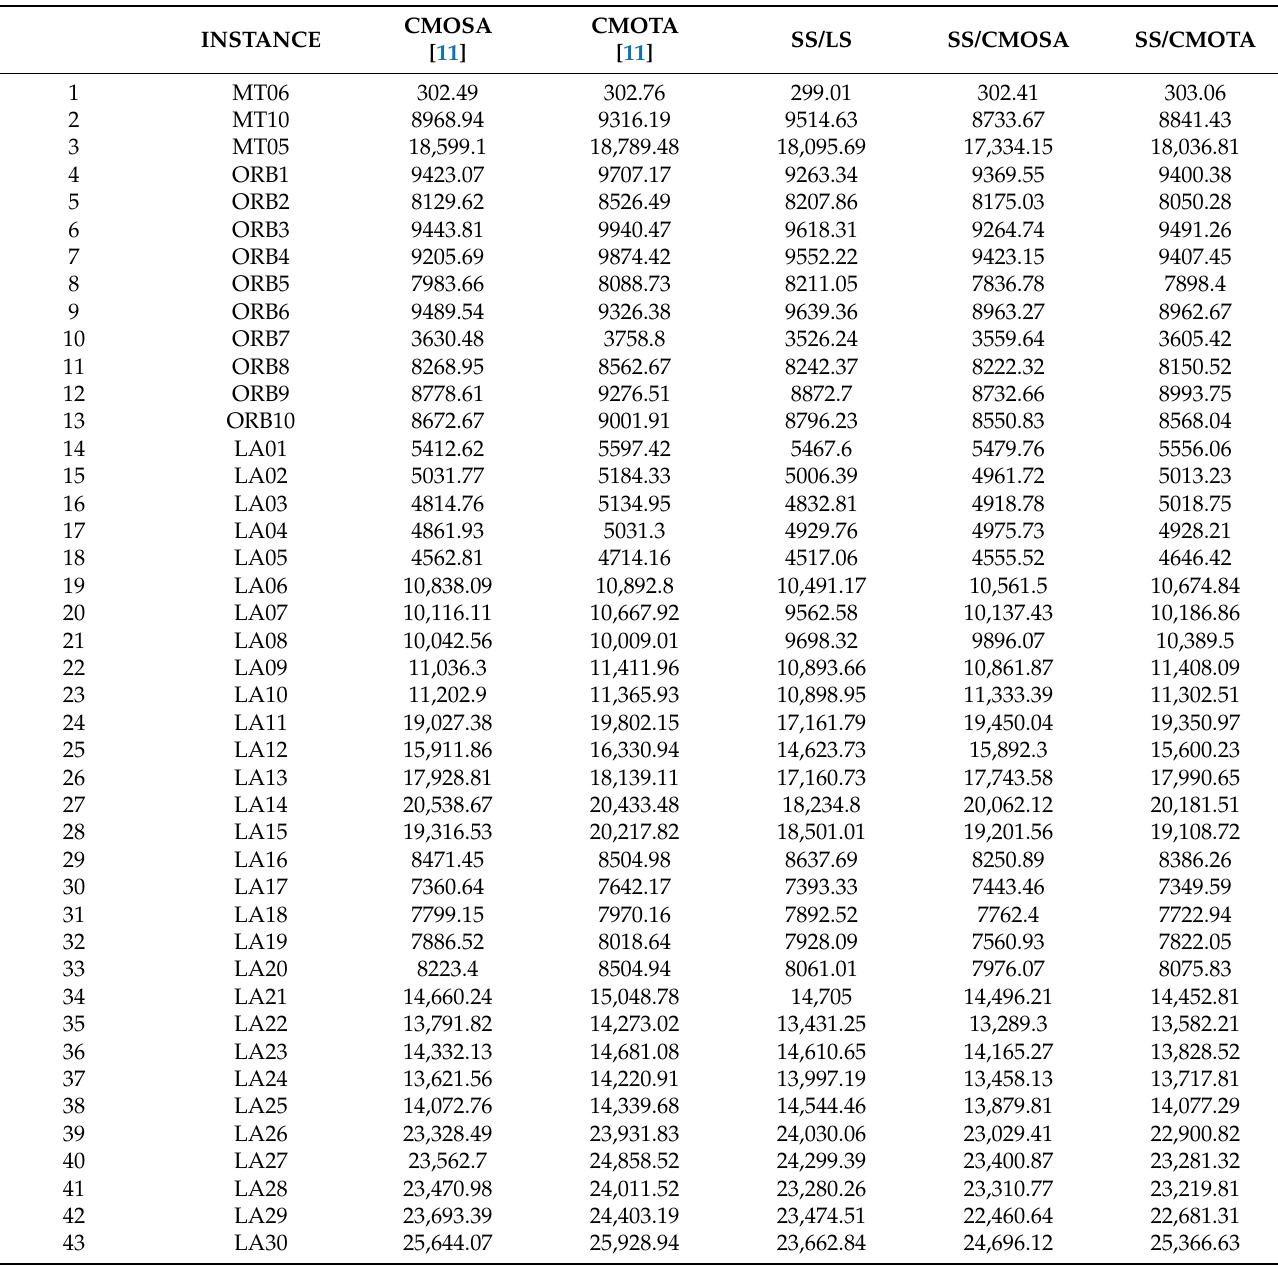
Table 3. CMOSA, CMOTA, SS/LS, SS/CMOSA, and SS/CMOTA results using MID